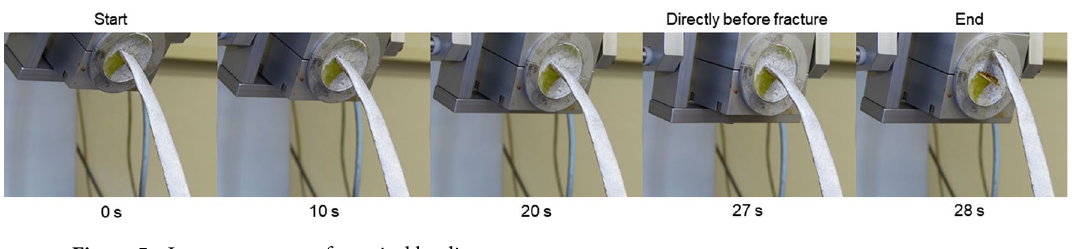
Figure 5. Image sequence of a typical loading